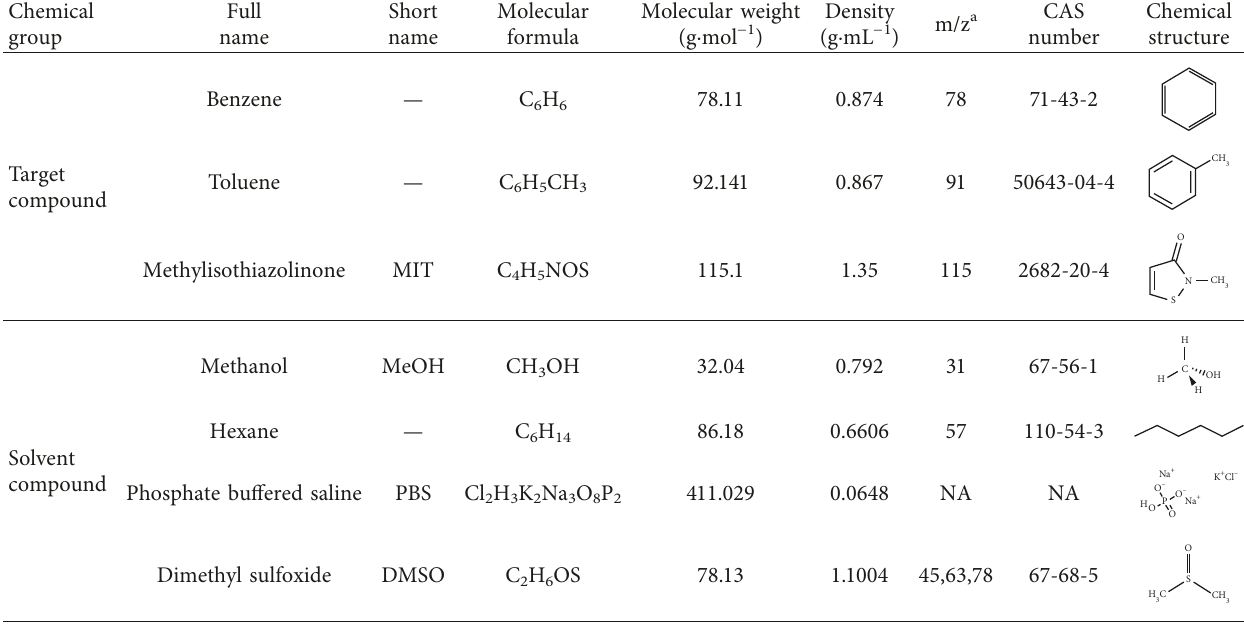
Table 1: Basic information on target compounds and